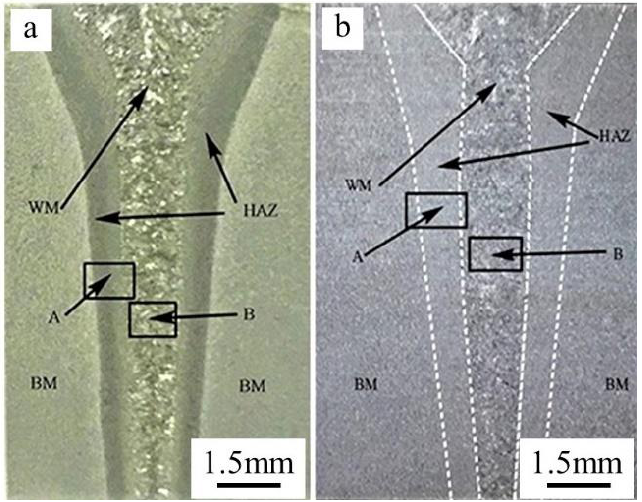
Figure 12. Macroscopic morphology of welded joint ( a ) before quenching and tempering treatment, and ( b ) after quenching and tempering treatment.